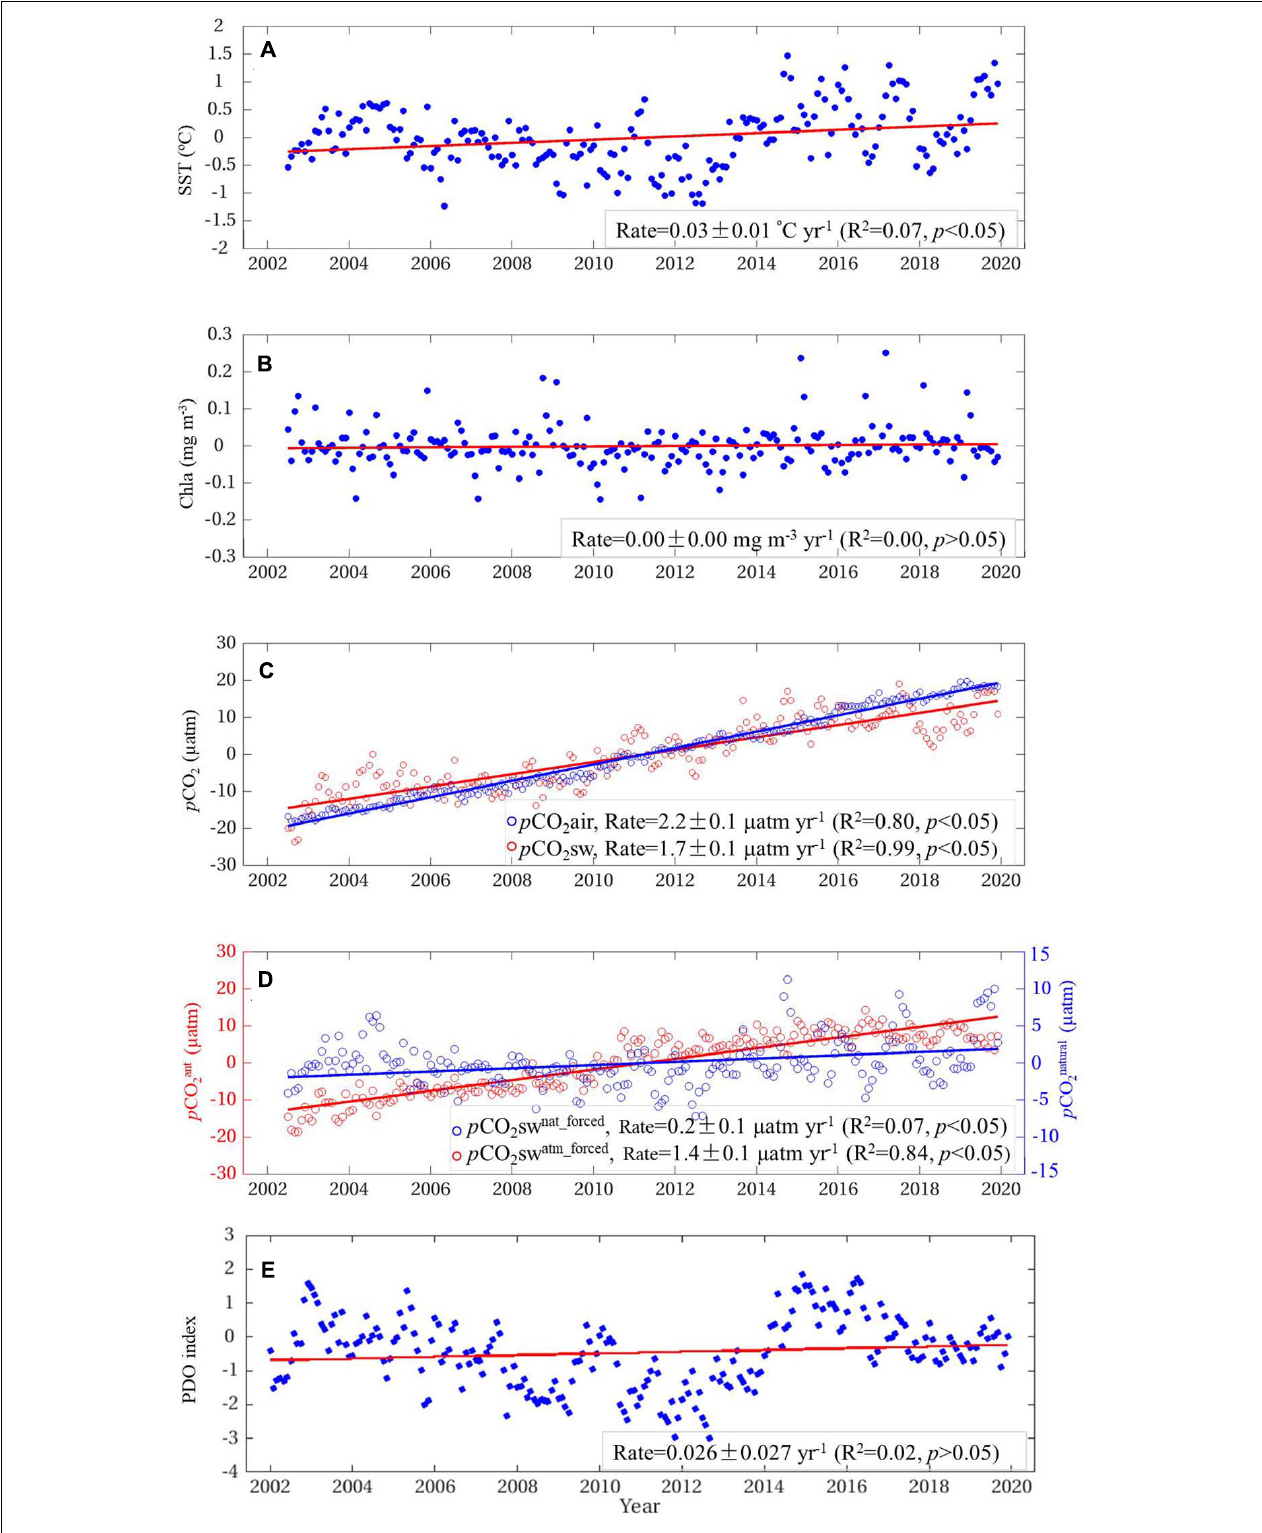
FIGURE 7 | Interannual variations of the monthly anomalies in SST (A) , Chla (B) , p CO 2 air and modeled p CO 2 sw (C) , modeled p CO 2 sw nat_forced and p CO 2 sw atm_forced (D) , and PDO index (E) in the period of 2002–2019.